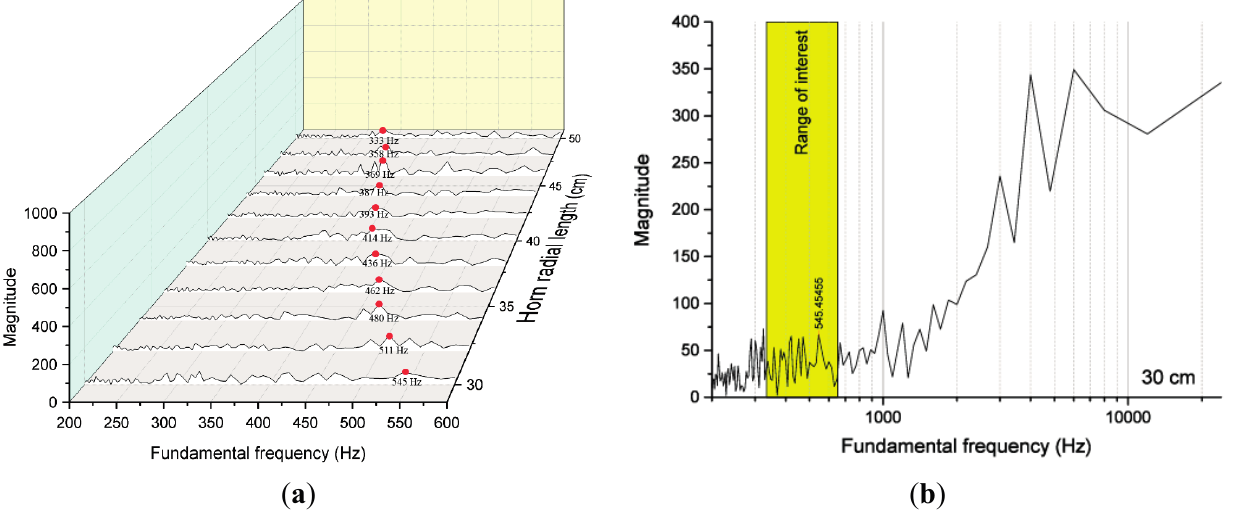
Figure 10. ( a ) Range-limited ML algorithm output for each radial length; and ( b ) entire output for the 30 cm radial length with a yellow shaded range for